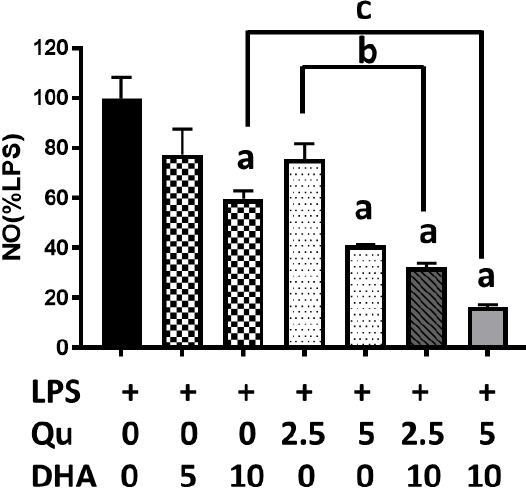
Figure 1. Effects of docosahexaenoic acid (DHA) (5 and 10 μM) and/or quercetin (2.5 and 5 μM) on lipopolysaccharide (LPS)-induced nitric oxide (NO) production in microglial cells. NO was measured using the Griess reaction protocol. NO data obtained from cells without LPS were subtracted from cells with LPS, and the differences were regarded as 100%. Results from three individual cell passages with triplicate assays from each passage are expressed as the mean ± SEM ( n = 3) and analyzed by one-way ANOVA followed by Tukey’s post-tests. “a” represents significant differences ( p < 0.01) between control versus LPS. “b” and “c” represent significant differences ( p < 0.05) between the indicated pairs.